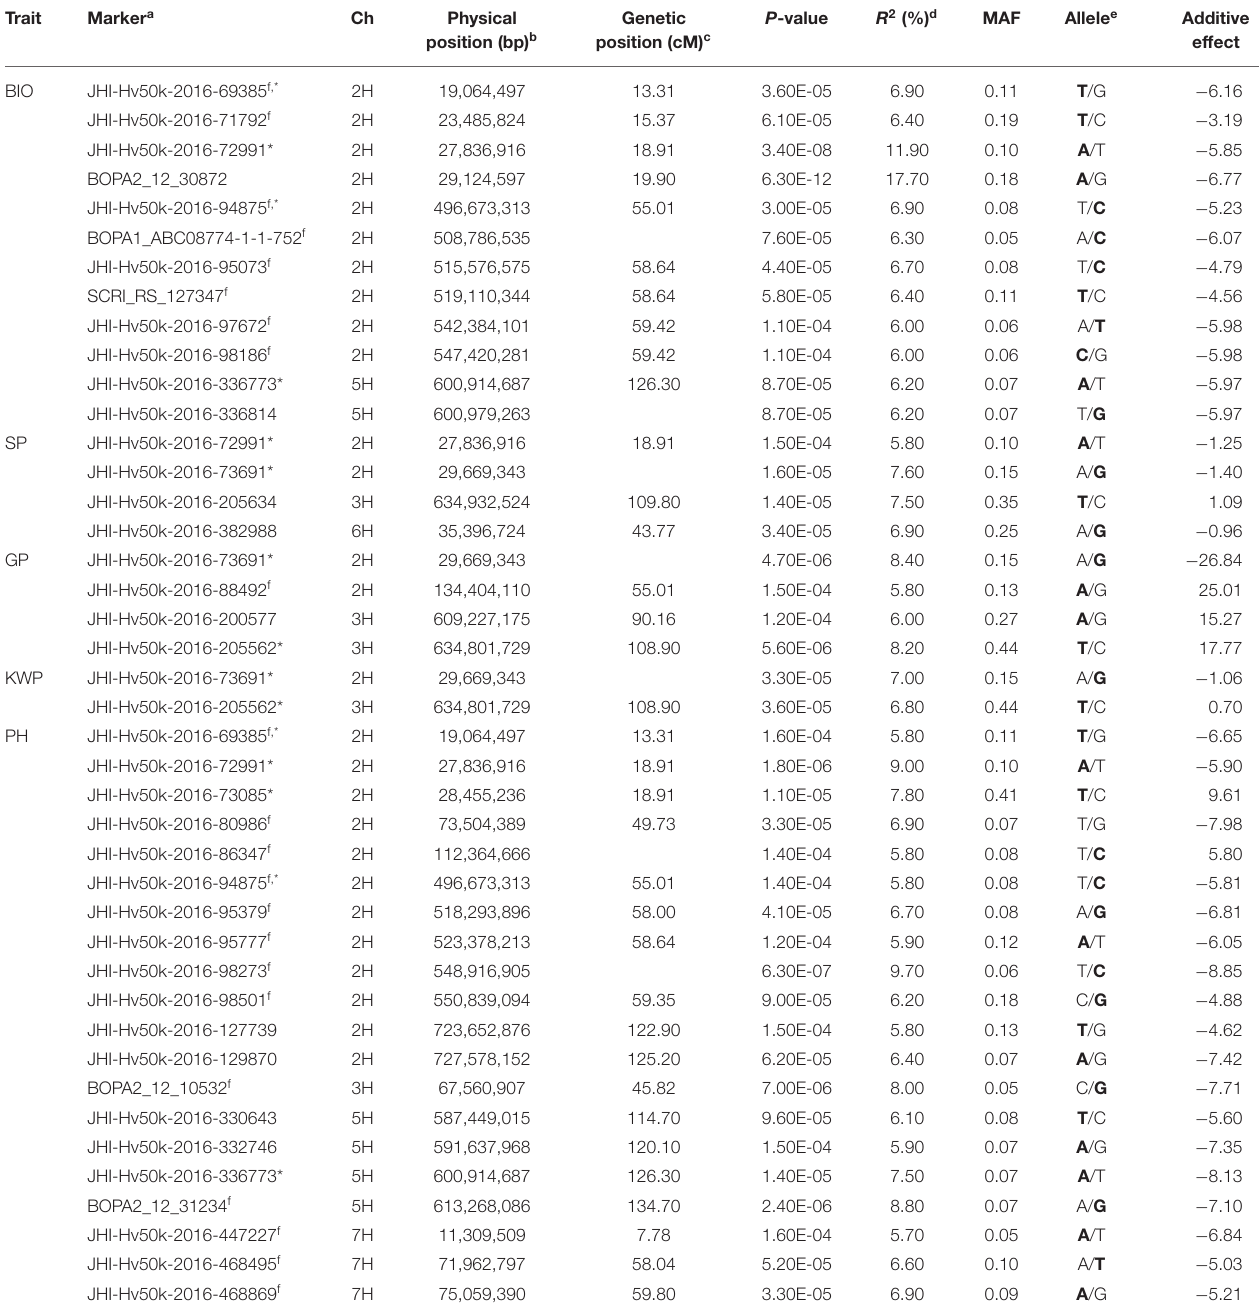
TABLE 3 | List of significant ( P < 1.6 × 10 − 4 ) marker-trait associations detected by GWAS using the MLM (Q + K) model in JMP Genomics and favorable alleles (bold) for the assessed traits in the overall control conditions.